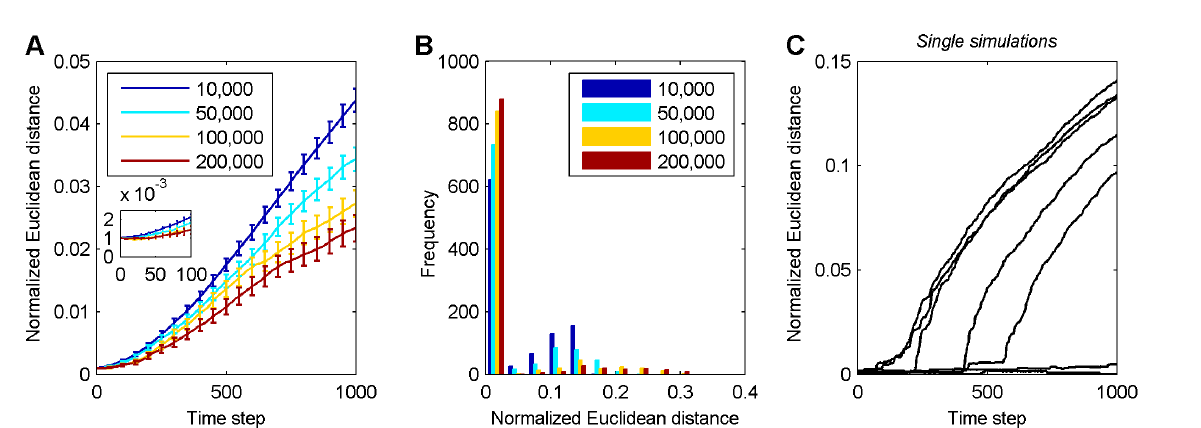
Figure 2. Long term development of normalized Euclidean distances between excitatory weight matrices of perturbed and unperturbed networks. A Averaged result over 1,000 simulations with error bars indicating standard errors of the mean. The inset shows a magnification of the initial 100 time steps. B Histogram of normalized Euclidean distances at 1,000th time step in A. In figures A–B, the color indicates the starting time of the perturbations as shown in the legend. C Examples of single simulations in the decay phase: the normalized Euclidean distance often stays at a low value for several hundred time steps but then displays an extensive amplification.